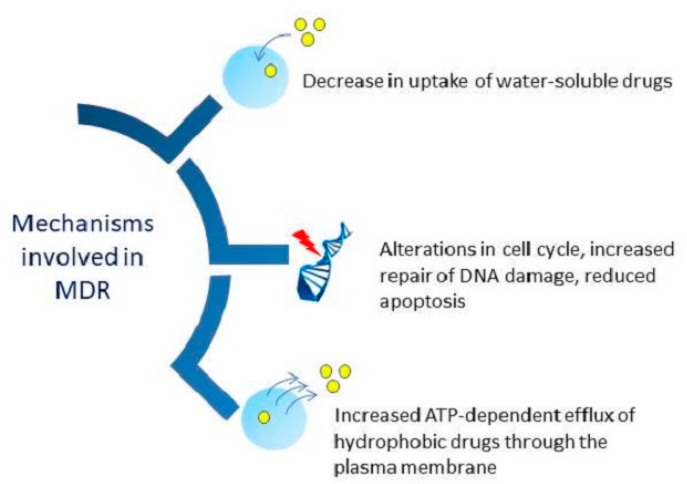
Figure 3. Different mechanisms involved in multi-drug resistance (MDR) by tumor cells